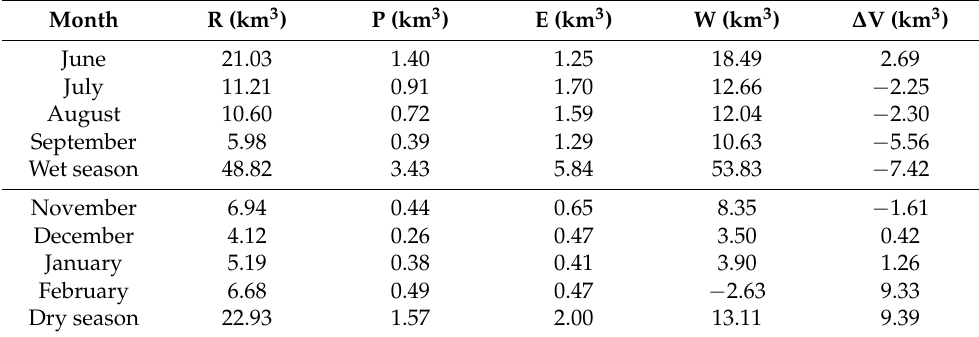
Table 1. Contributions of the factors to lake storage